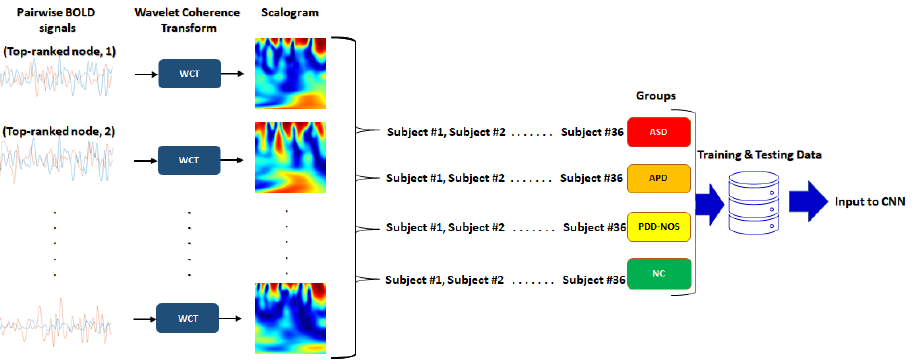
Figure 2. Wavelet coherence of pairwise BOLD signals between top-ranked node and 115 brain